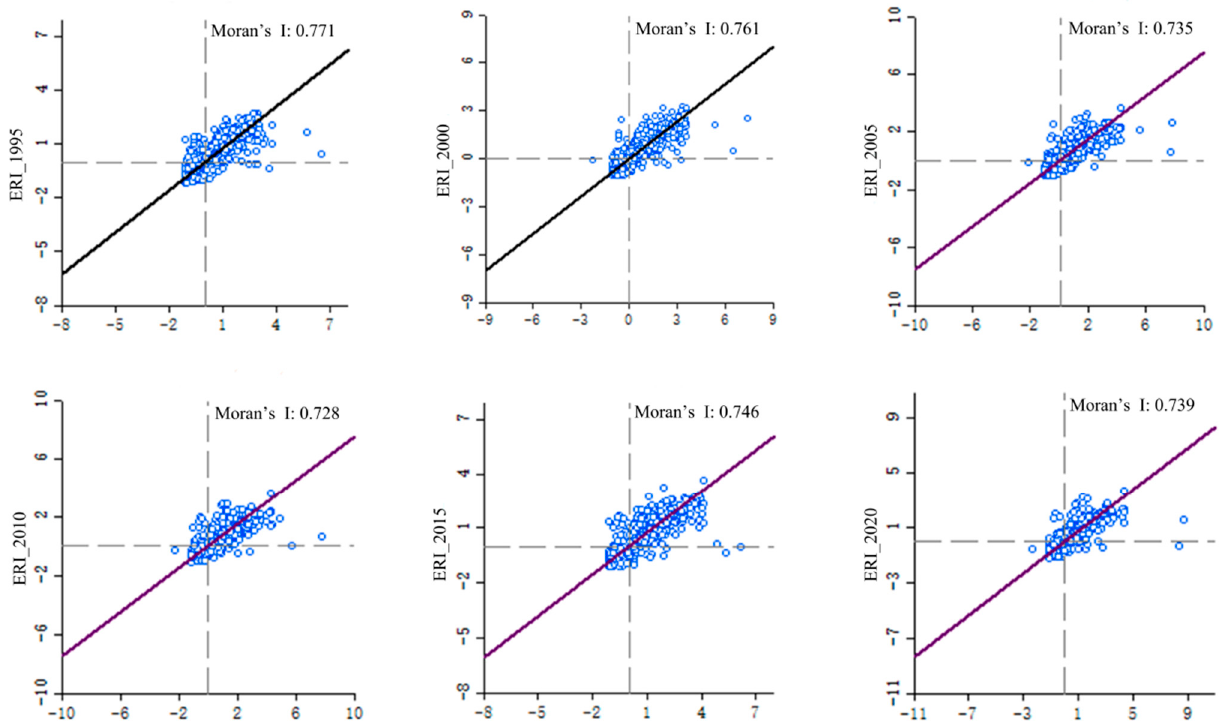
Figure 5. Moran scatter of ecological risk index of Dongting Lake